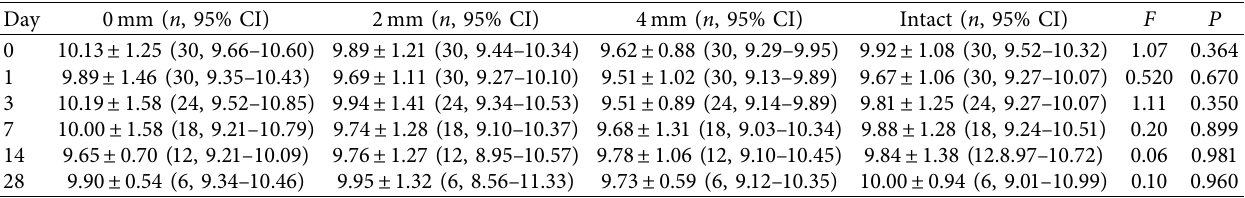
Table 3: Changes in thermal paw withdrawal threshold (s) in the C7 neurotomy